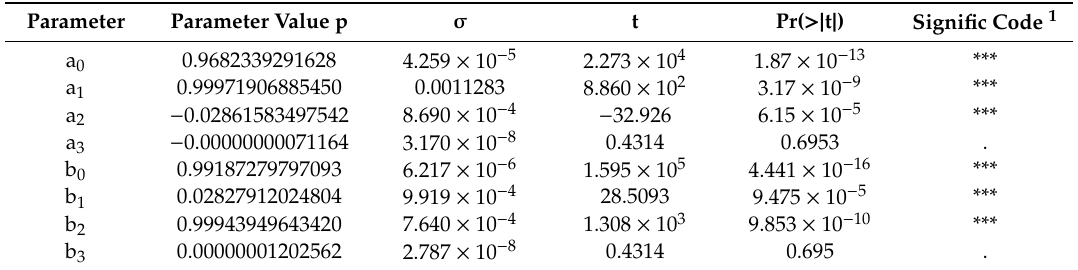
Table A6. Bilinear transformation parameter value p, standard error σ , t value (t = P significance codes.